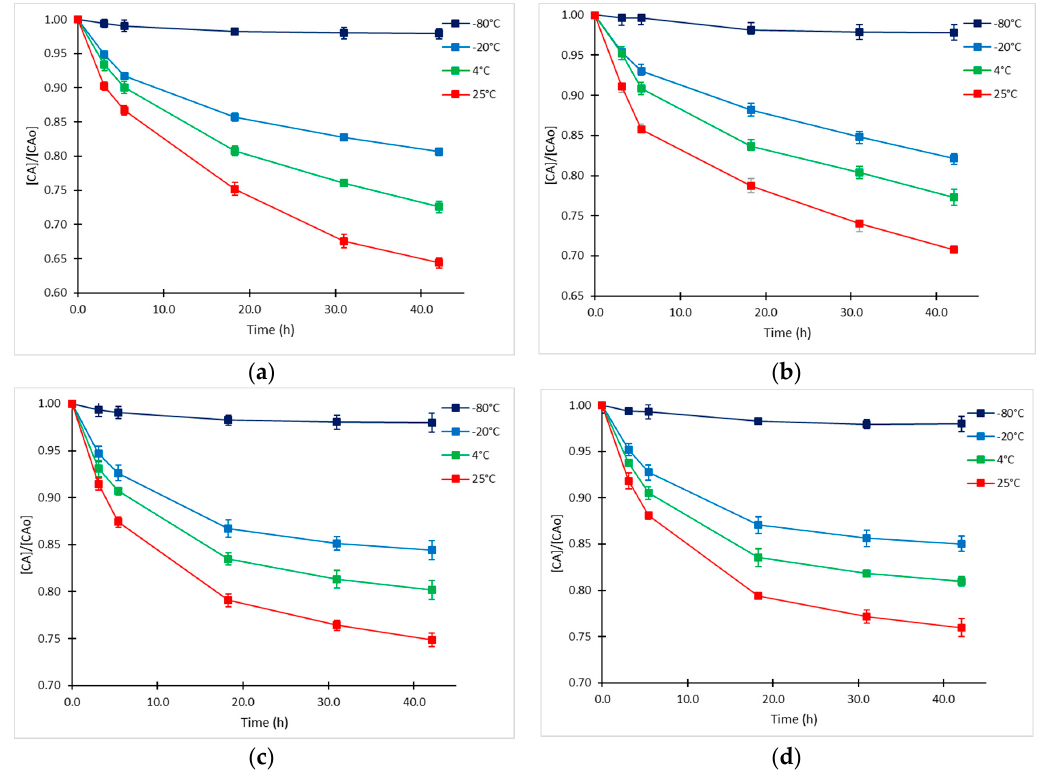
Figure 1. Time courses of relative CA concentration at − 80, − 20, 4 and 25°C and different CA initial concentrations (CA o ). ( a ) CA o = 126.7 mg/L; ( b ) CA o = 65.5 mg/L; ( c ) CA o = 25.3 mg/L; and ( d ) CA o = 16.3 mg/L.